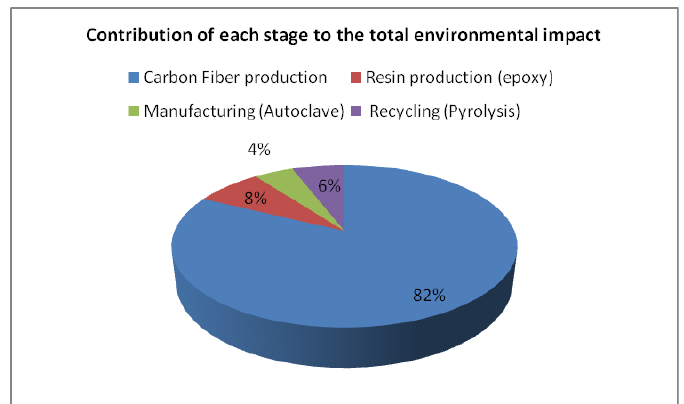
Figure 3. Contribution of each stage to the total environmental impact.